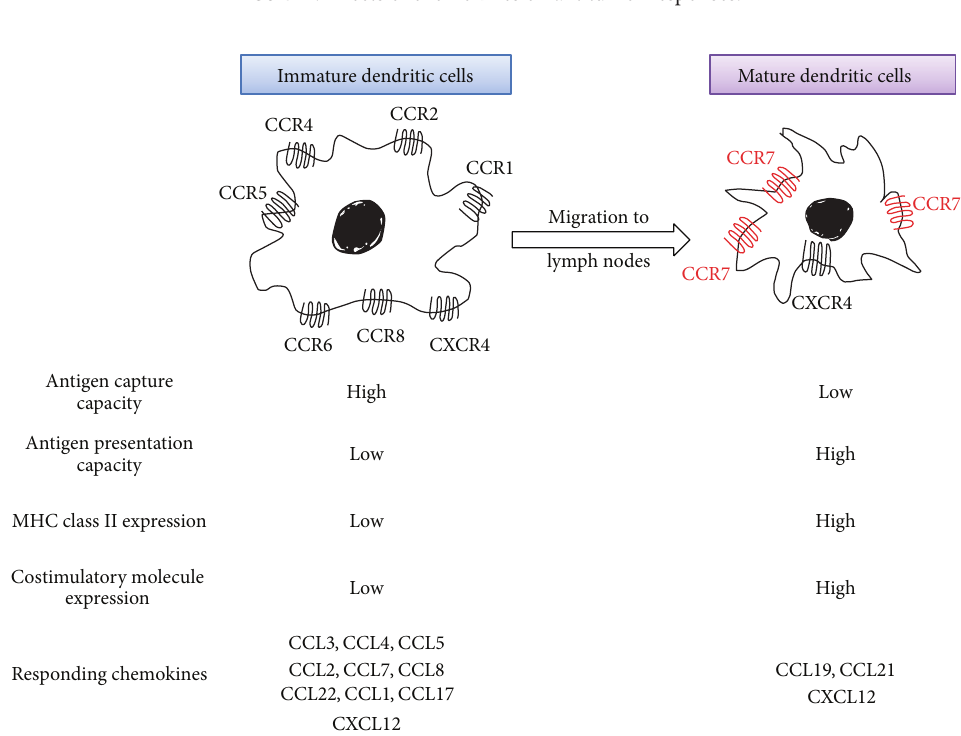
Figure 2: Effects of chemokines on antitumor responses.